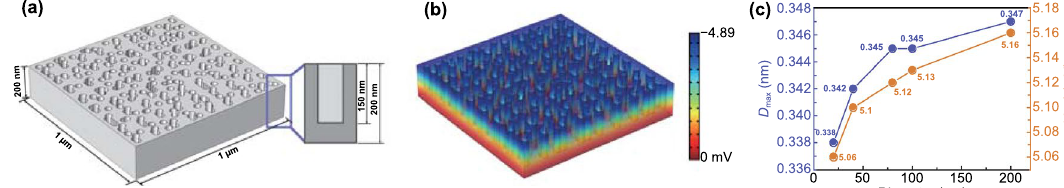
Fig. 2 a Geometry Schematics of the N doped 4H‑SiC NHAs. b Distribution of the V in NHAs at a pressure of 1 MPa. c The tendency of D max and | V max | with the increase of nanohole